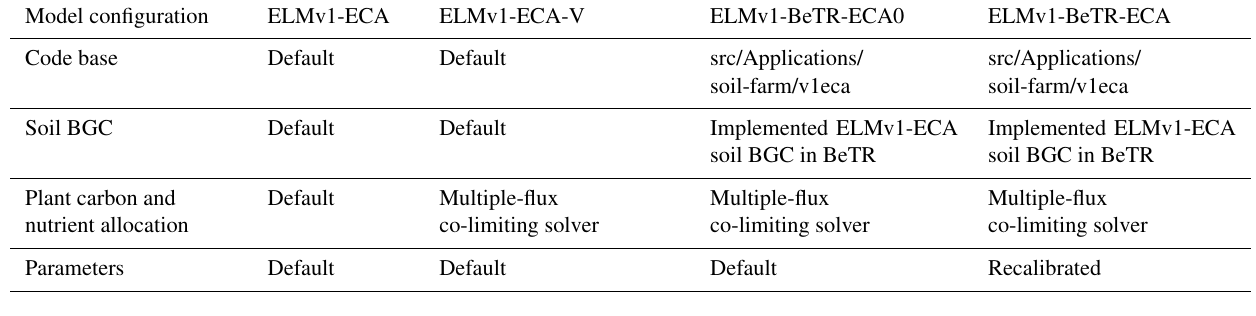
Table 1. Summary of the configurations for the four global simulations.